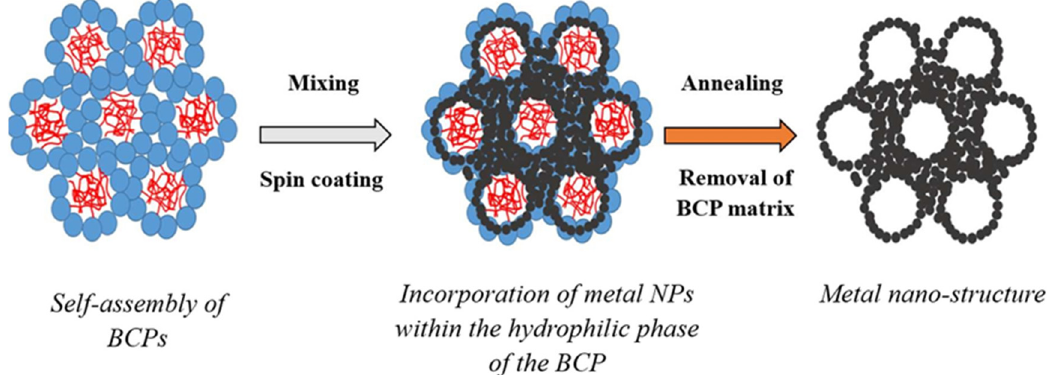
Figure 1. Schematic of the formation of the metal nano-porous networks by templating metal nano-particles (NPs) across self-assembled block-copolymer (BCP) materials assembled as lyotropic liquid crystals (LLC) without pore